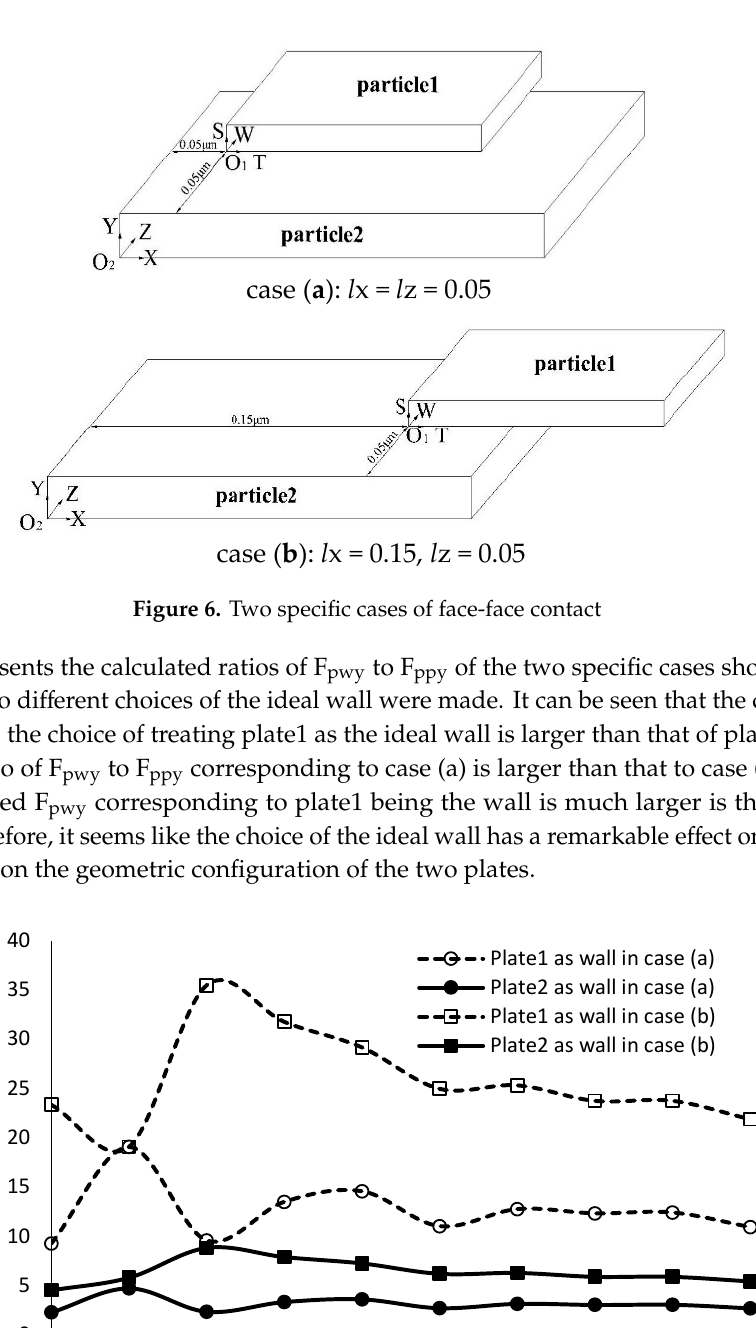
Figure 7. Comparison of the calculated forces with different choices of the ideal wall.